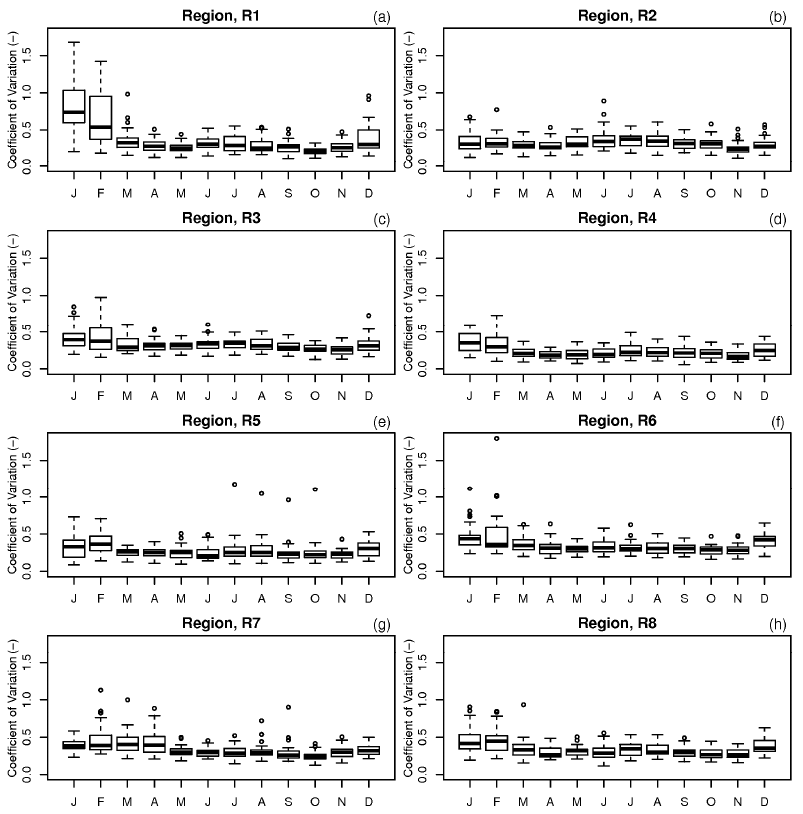
Figure 2. Box and whisker plot of mean monthly coefficients of spatial variations (1976–2006) of the eight delineated rainfall regions (Panel a to h ). The solid line is the median, the height of the box is the difference between the third and first quartiles (IQR). Any data observation which lies 1.5 IQR lower than the first quartile or 1.5 IQR higher than the third quartile is considered an outlier in the statistical sense, indicated by open circles.